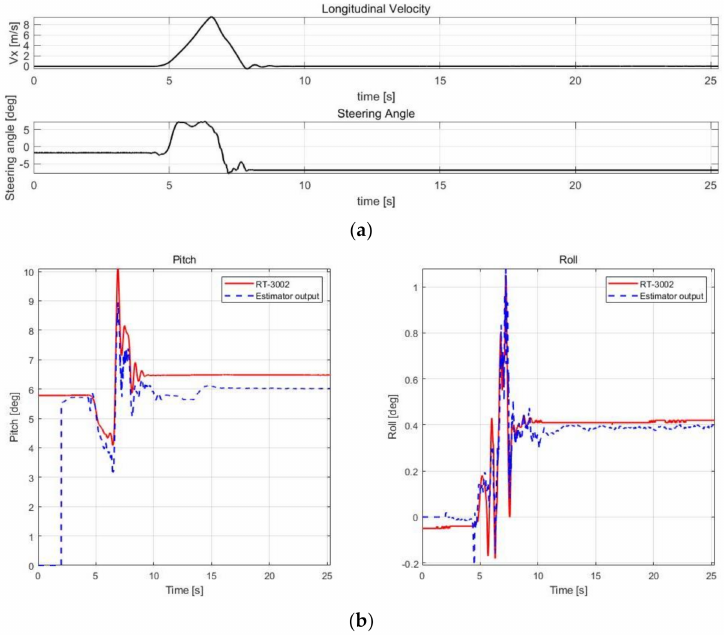
Figure 6. Validation results of Case 2. ( a ) Speed and steering profile. ( b ) Roll/pitch estimation